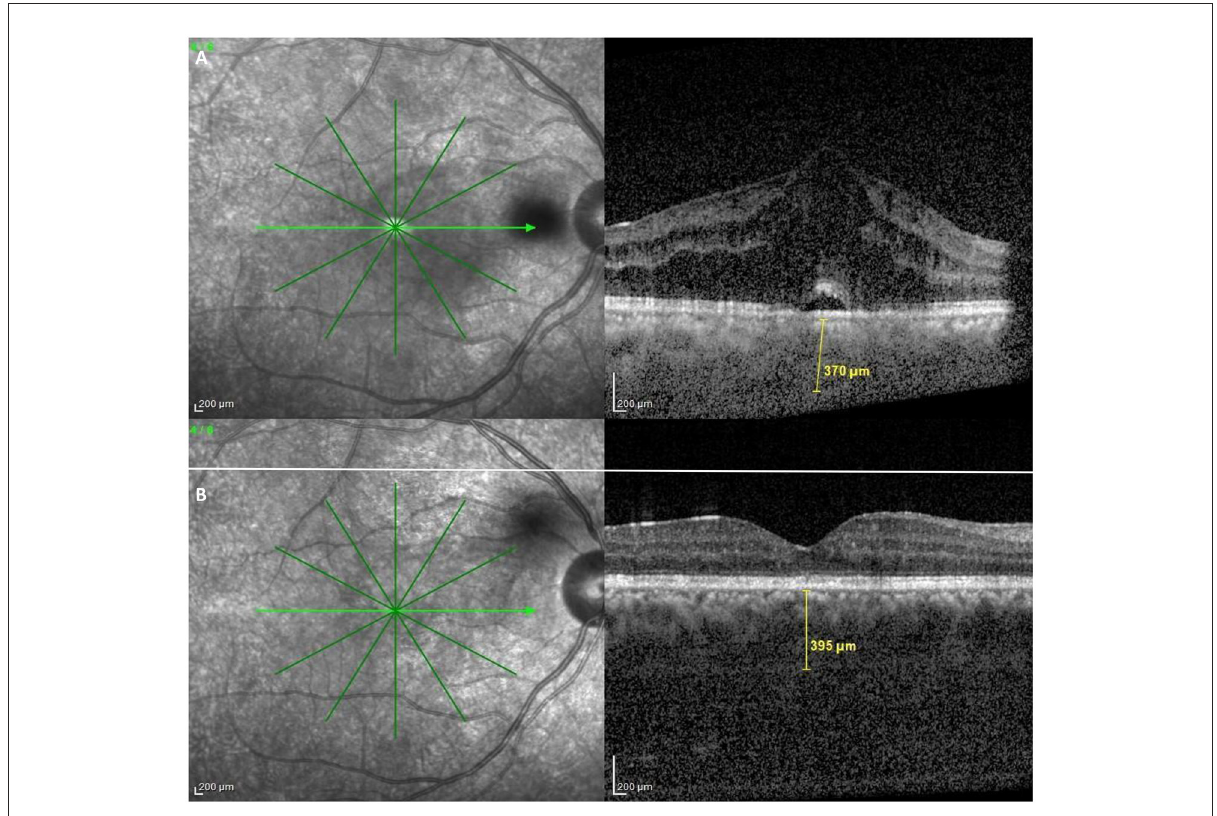
FIGURE5 OCT findings in Behçet Uveitis. (A) OCT of an active BU patient showing center involving cystoid macular edema, neurosensory detachment, epiretinal membrane and increased subfoveal choroidal thickness. (B) OCT of an inactive BU patient showing diffuse parafoveal edema, epiretinal membrane and also above average subfoveal choroidal thickness (Images courtesy of Dr. Wassef A,